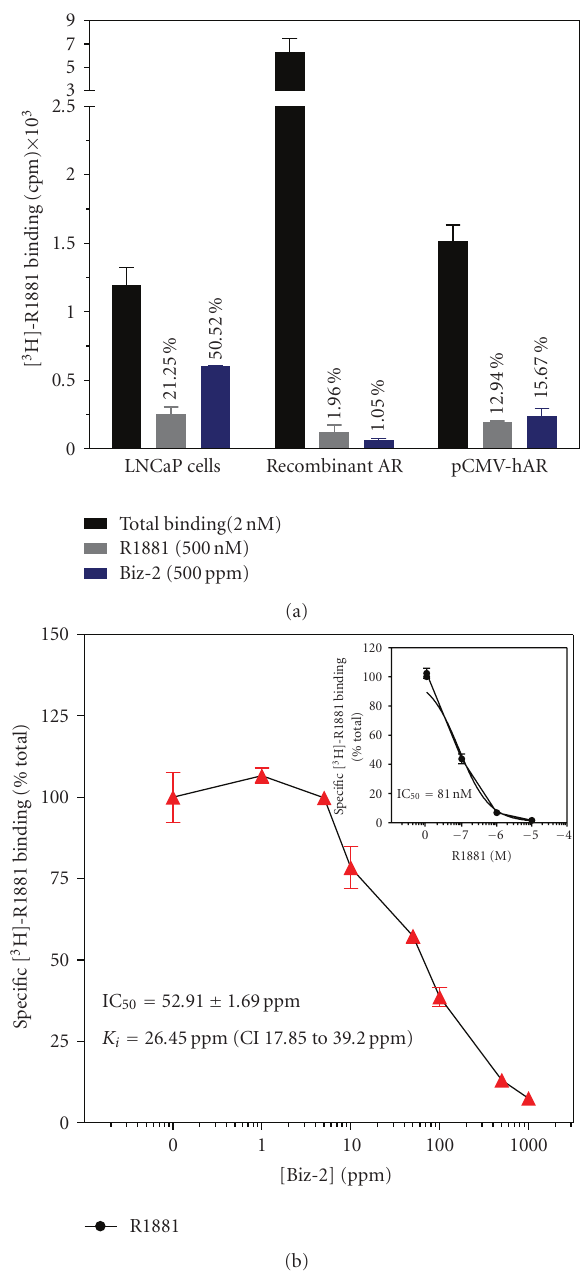
Figure 4: Biz-2 competes for AR binding in LNCaP cells. AR protein from LNCaP cells, cells transfected with pCMV-AR, or purified recombinant AR protein was incubated with 2 nM [ 3 H] R1881 with or without increasing concentration of Biz-2 for 18 hours at 4 ◦ C. Bound and free [ 3 H] R1881 were separated using the HAP assay (see Section 2). Each data point represents the mean ± SEM of a representative experiment performed in triplicate. The IC 50 was calculated from the competition curve using a one-site competition model. K i was calculated by K i = IC 50 /(1 + [ligand]/ K d ) in which K d and ligand concentration [ligand] were set to 1 and 2nM, respectively. (a) Single-point assay in the presence of 500X excess R1881 (number above the bar is % of total binding). (b) Displacement curve of [ 3 H] R1881 by Biz-2 (insert is displacement curve of [ 3 H] R1881 by inert R1881). N = 2 separate experiments performed in